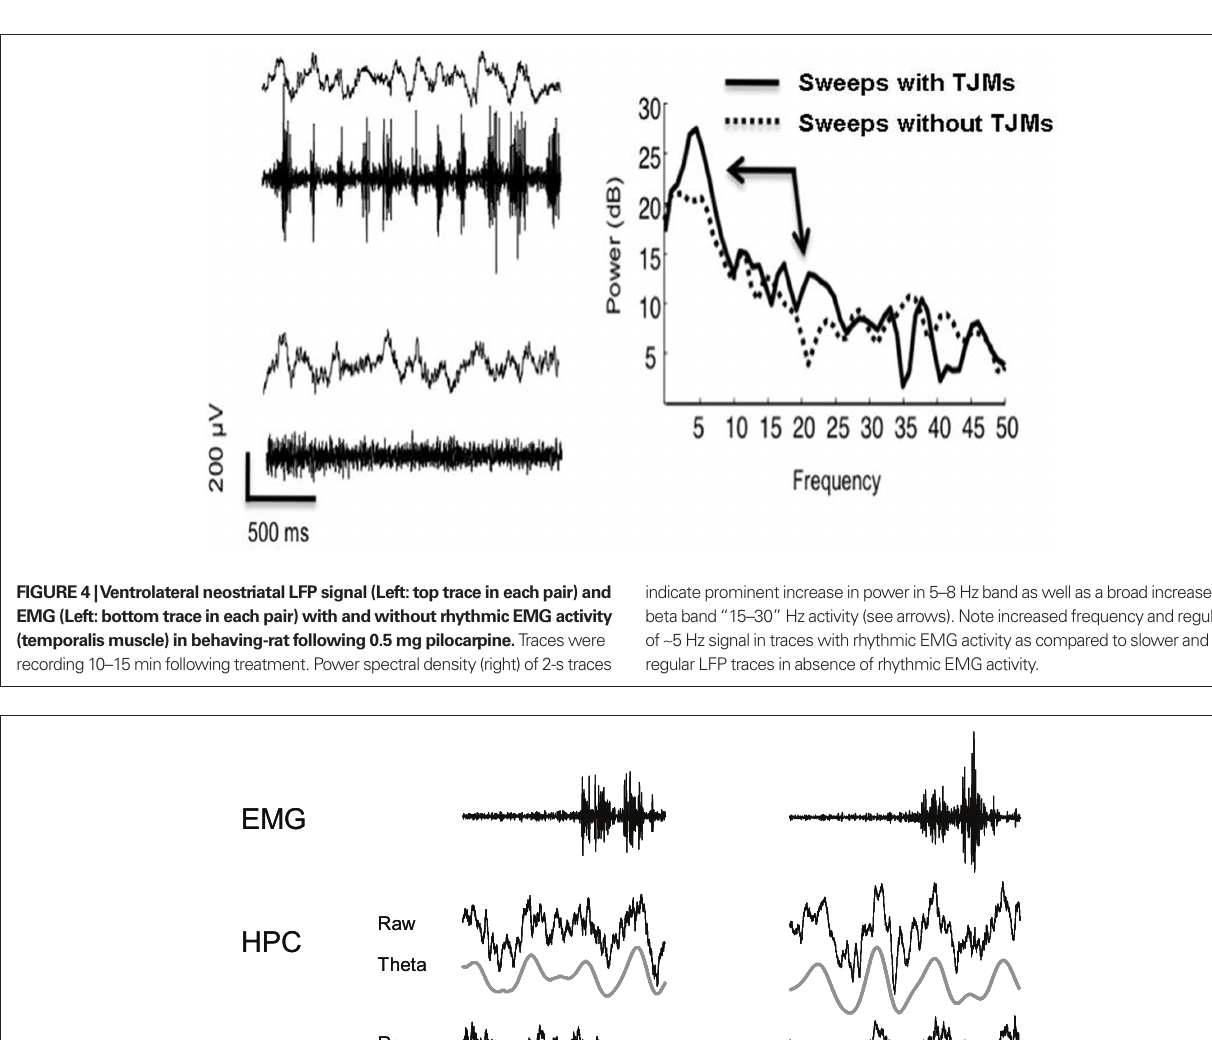
phenomena occur independently of each other and are not correlated. Additionally, no epileptiform activity is present during the occurrence of either jaw movement burst at the dose of 0.5 mg/kg pilocarpine. Epileptiform activity only becomes apparent at a much higher dose of pilocarpine (i.e., 50 mg/kg pilocarpine, data not